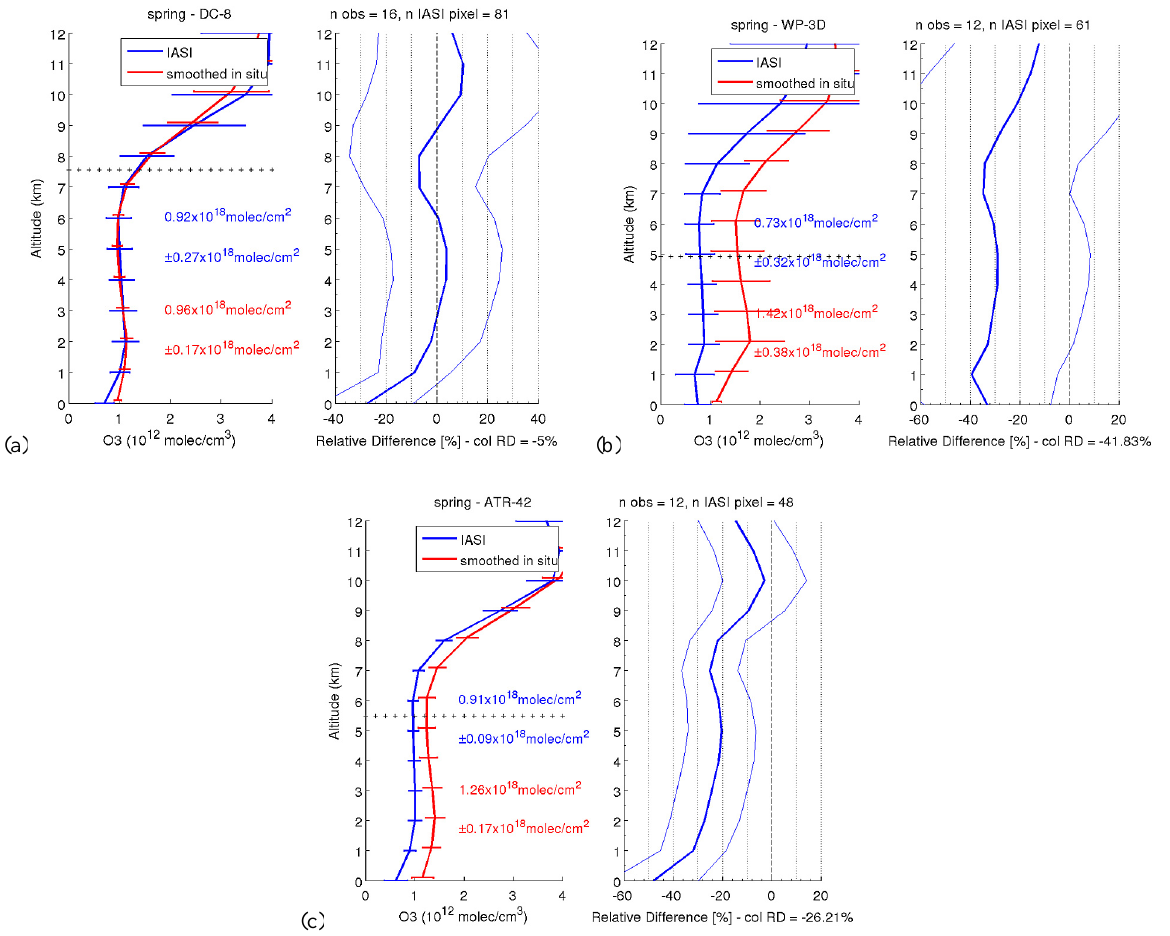
Fig. 6. Left panel: average IASI O 3 profiles (blue lines) and smoothed in situ profiles (red lines) in units of 10 12 moleculescm − 3 for each spring aircraft campaign; the horizontal dashed black line represents the mean position of the maximum altitude reached by each particular aircraft. Error bars represent the variability of averaged smoothed data (standard deviation ± 1 σ) . The coloured numbers indicate the average [0–8km] columns in 10 17 moleculescm − 2 together with the standard deviation. Right panel: average relative difference (RD) in % (thick blue lines for profiles and numbers below the graphs on the right are the average differences for [0–8km] columns) and ± 1 σ (thin blue lines). The number of in situ observations and IASI co-located pixels are noted at the top of the panels on the right. The relative differences are calculated as follows: [(IASI – smoothed in situ)/(smoothed in situ)] × 100%. The smoothed in situ profiles are the in situ aircraft measurements completed with the ACE-FTS climatology and convolved with IASI AK (see text for details). Results are shown for the DC-8 (a) , the WP-3D (b) and the ATR-42 (c) . The mean ECMWF dynamical tropopause is at 8, 8.5 and 7.8km,